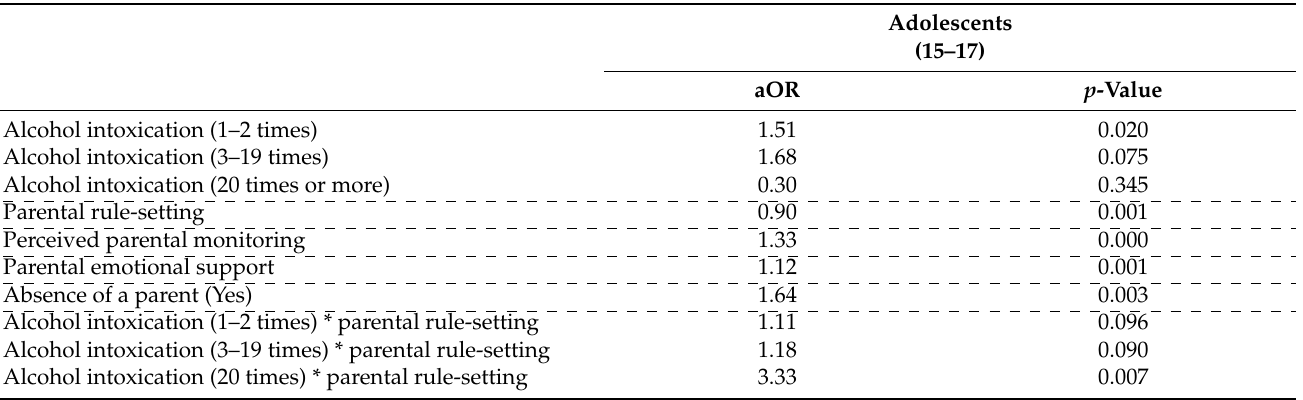
Table 5. Binary logistic regression model between alcohol intoxication, parenting indicators, and violent behaviour in the past 12 months among adolescents: testing the modification effect of parental rule-setting.